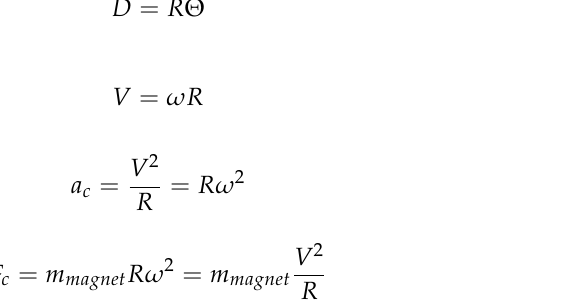
For a crank-slider harvester which utilizes the style presented in Figure 1, the induced voltage ( U v ) from the motion of a conductor within a magnetic field ( B ) over a length of wire ( L ) at a velocity ( ˙ x ) is shown in Formulas (15), (16), and reduced to (17) [36]. The values for B are assessed for theoretical analysis in two ways: using the COMSOL values seen in Figure 9 and using the physical readings from a WT10A Teslameter. Those values are plotted in Figure